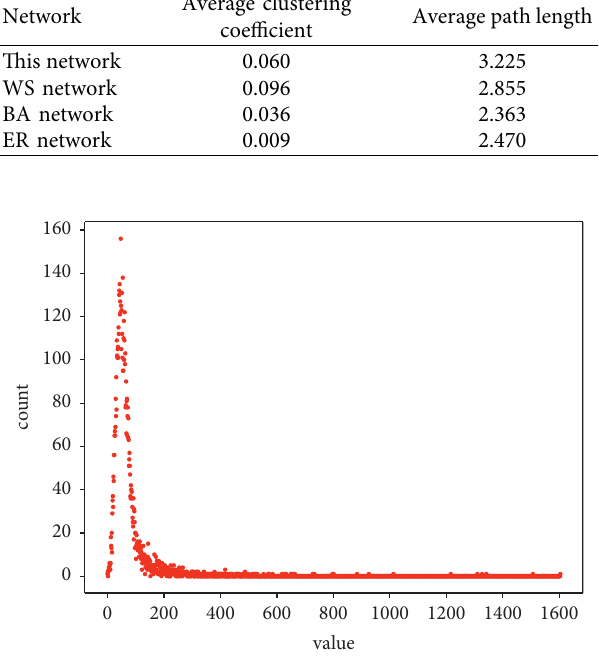
Figure 3: Degree distribution of social networks based on